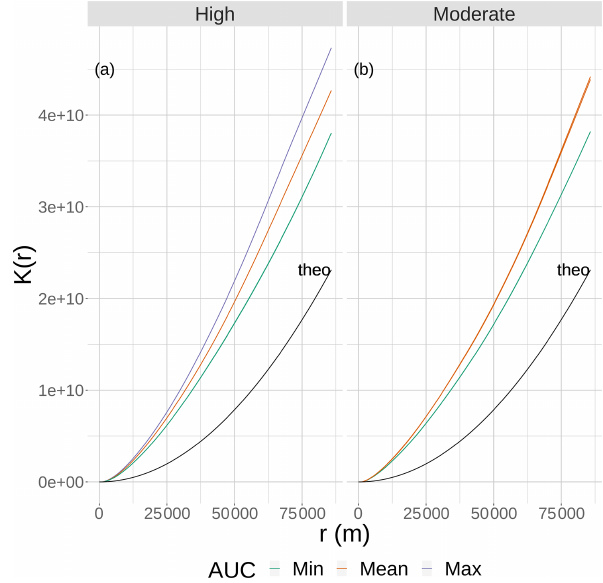
Figure 2. The results of Ripley’s K function versus the neighbor- hood size ( r ) for eight static 2-D snapshot maps of DO from the bot- tom layer of the FVCOM-WASP simulation of 20–30 August 2002. The snapshots are defined in Table 1. Ripley’s K values (lines) are shown for maps split into high (a) and moderate (b) sublethal ar- eas and by AUC values with each panel. There are lines for the two minimum and single mean and maximum AUC values for the high sublethal area and for the minimum and to mean AUC areas for the moderate sublethal area. Some of the curves overlap and are not easily distinguished. The line labeled “theo” represents the relation- ship between Ripley’s K and r for the theoretical condition when the spatial variability in sublethal DO cells is